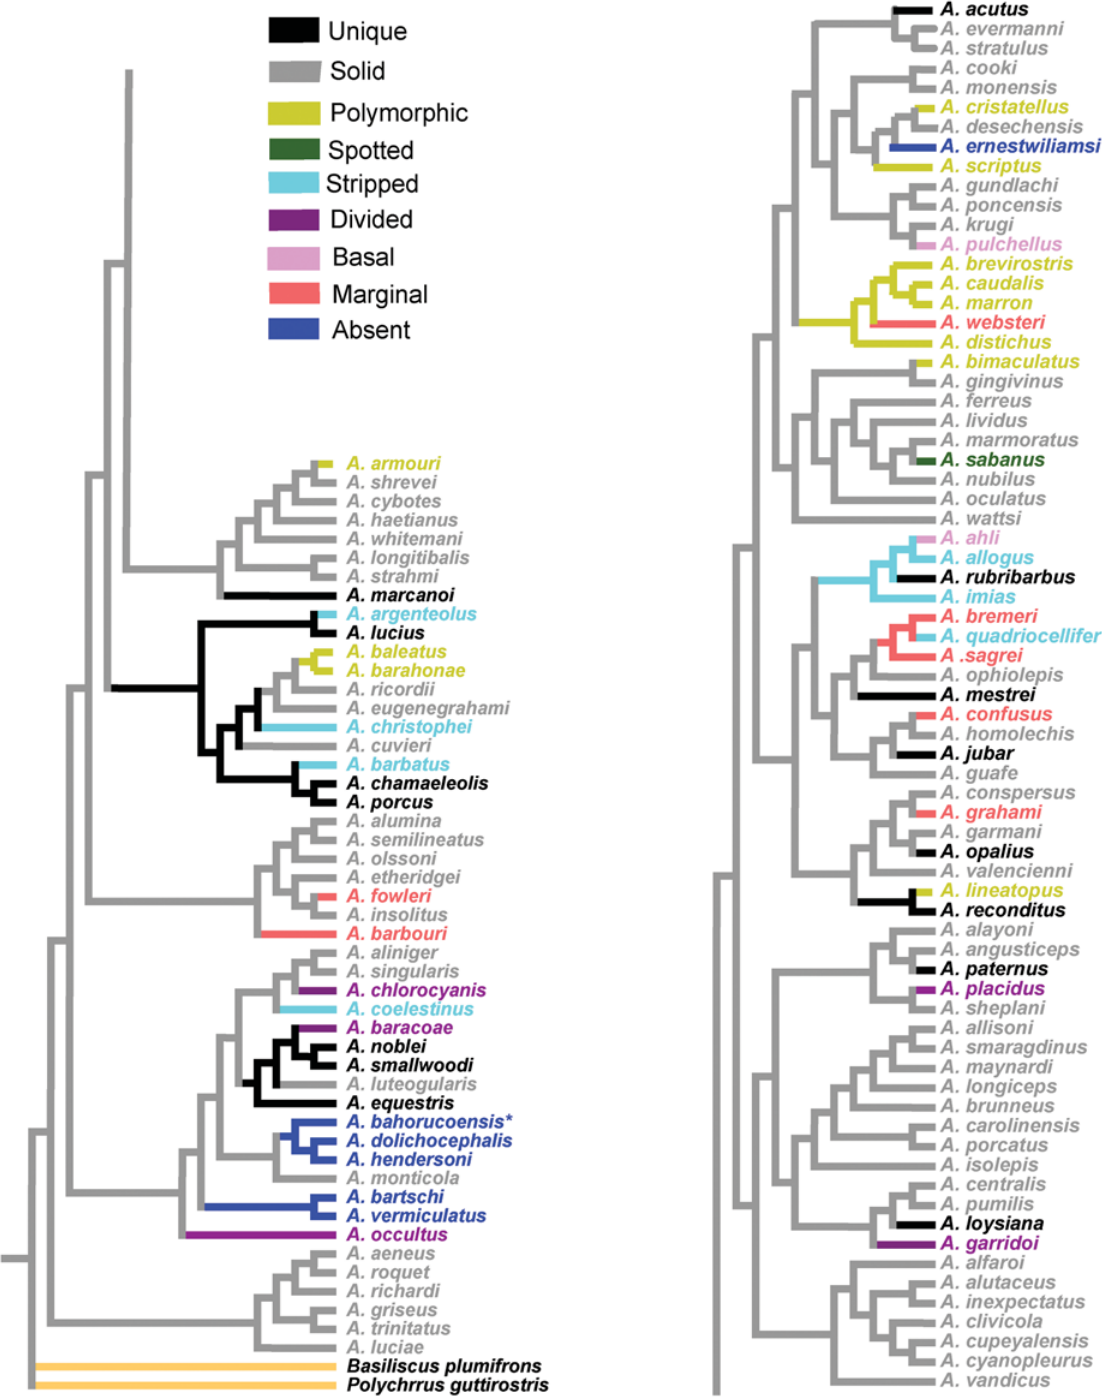
Figure 3. Dewlap patterns mapped on to a phylogeny for Anolis species. Patterns are indicated in color on the phylogeny (color legend upper left). Polymorphic species are those that exhibited two or more pattern morphs (see text for how this was handled analytically). Patterns are defined in the text. This tree includes all of the species used in the tests for phylogenetic signal of dewlap characters. The tree is modified from Nicholson et al.’s [20] anole tree but has been pruned of taxa for which dewlap information was lacking. Analyses were based on an ultrametric version of this tree, but is reproduced here in cladogram form for enhanced viewing of dewlap pattern information.